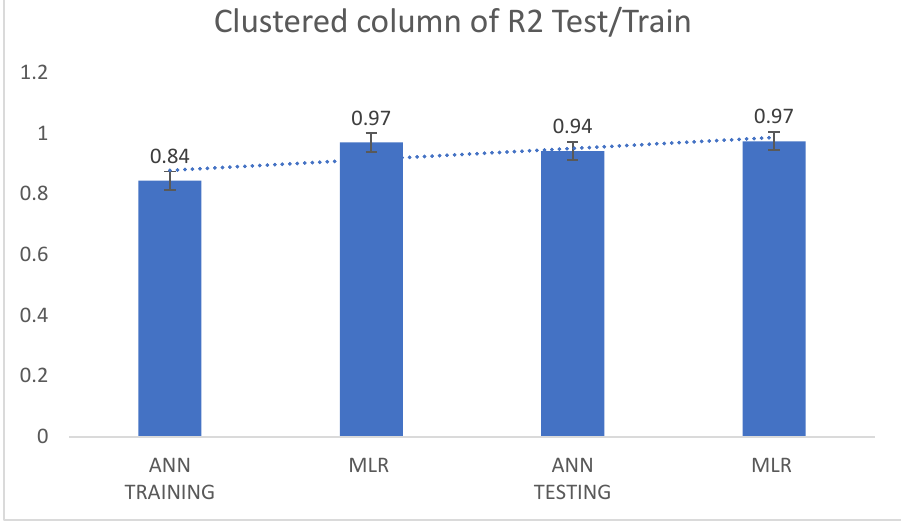
Figure 8. MLR testing data showing experimental and predicted values.